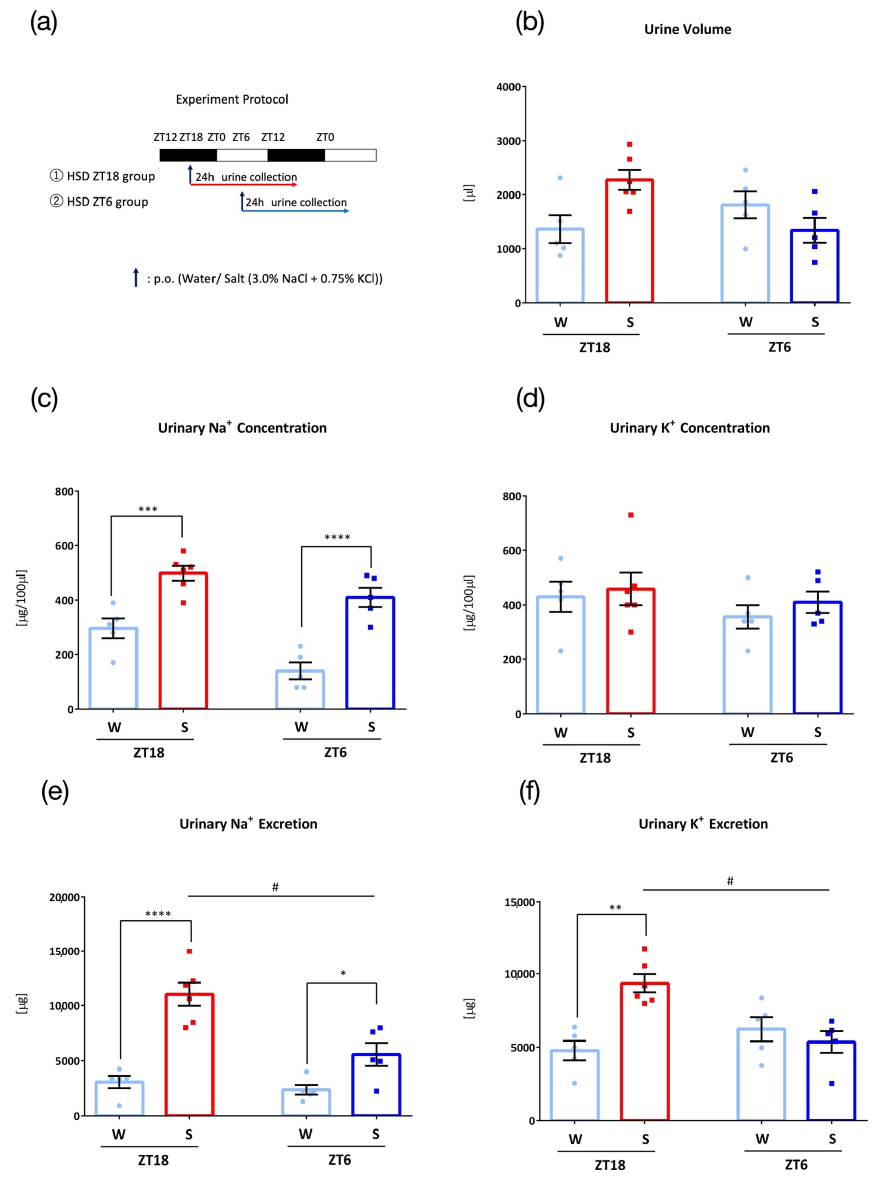
Figure 4. Urinary excretion after administration of salt load with a high-salt diet (W: Water administration, S: Salt administration). ( a ) Experimental protocol, ( b ) Urine volume, ( c ) Urinary Na + concentration, *** p < 0.001, **** p < 0.0001 (vs. Water) Sidak. ( d ) Urinary K + concentration, ( e ) Urinary Na + excretion, # p < 0.01 (vs. ZT18), * p < 0.05, **** p < 0.0001 (vs. Water) Sidak. ( f ) Urinary K + excretion, # p < 0.01 (vs. ZT18), ** p < 0.01 (vs. Water) Sidak. Data are represented as mean ± SEM (ZT18 group: n = 5–6, ZT6 group: n =